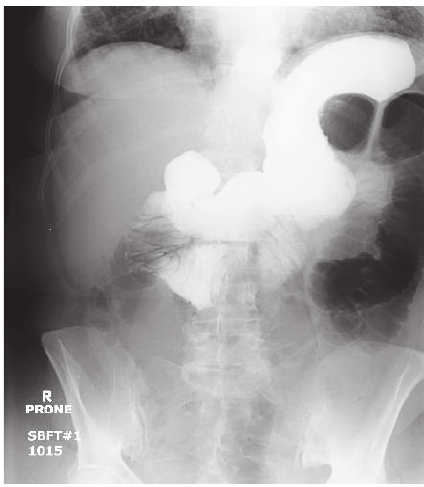
Figure 3: Gastrografin small-bowel follow-through demonstrated failure of contrast to pass into the colon.